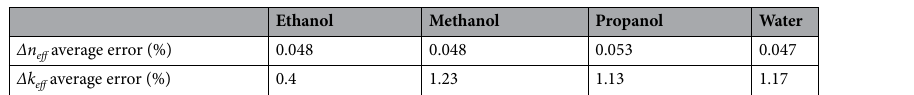
Table 1. The average error in the detected mode effective index change both real Δn eff and imaginary Δk eff for different sensing media.